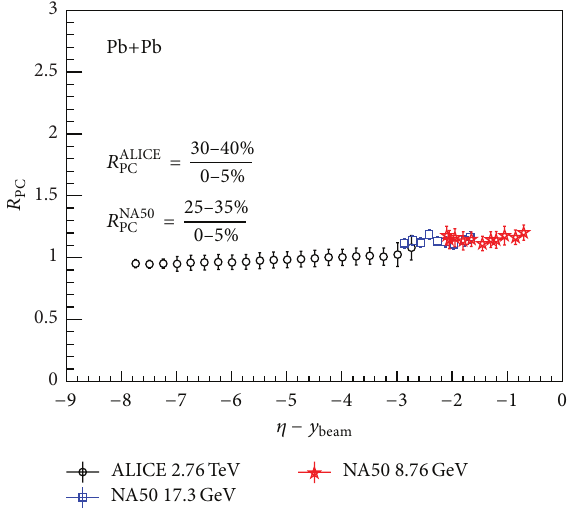
Figure 10: 𝑅 as a function of 𝜂 󸀠 = 𝜂 − 𝑦 PC at three different